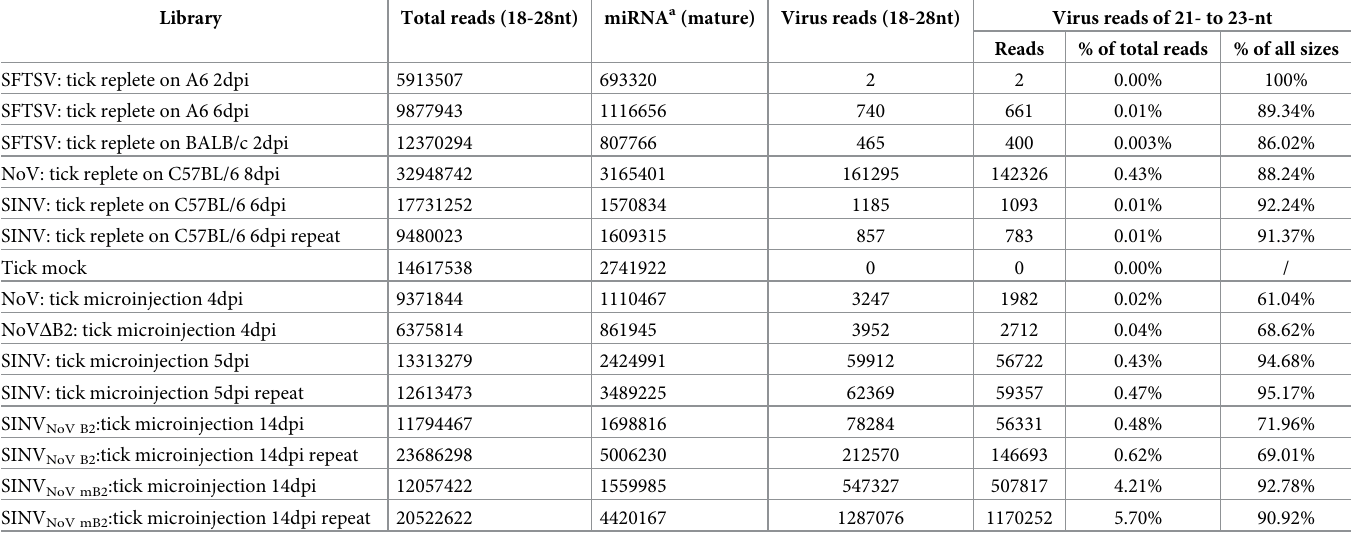
We next evaluated the antiviral RNAi activity of these ticks by deep sequencing of small RNAs (sRNA-Seq). Consistent with the amplification of SFTSV, less vsiRNAs were detected in ticks at 2 dpi (Fig 1C, top panel). Of note, along with SFTSV replication, vsiRNAs with a clear peak length of 22 nt from both strands appeared in ticks at 6 dpi (Fig 1C, bottom panel, and Table 1). Additionally, compared to L and M segment of SFTSV, S segment produced more abundant vsiRNAs from both genome and antigenome (Fig 1C, bottom panel). Moreover, given that IFN-competent WT mice can also be used to establish a SFTSV infection model [64,65], we then performed a comparable experiment on WT mice and found that SFTSV also induced the production of canonical vsiRNAs in ticks feeding on BALB/c mice at 2 dpi (Fig 1D and 1E). These 21- to 23-nt vsiRNAs were predominantly clustered in the S segment from both polarities (Fig 1E), further indicating that the S segment is more accessible to tick RNAi machinery. NoV and SINV are frequently used model viruses to dissect antiviral RNAi [66]. We next expected to know the potential of those virus to dissect antiviral RNAi in ticks followed the same infection route (S1B and S1C Fig). After successful infection of H . longicornis ticks by Table 1. Contents and properties of the small RNA